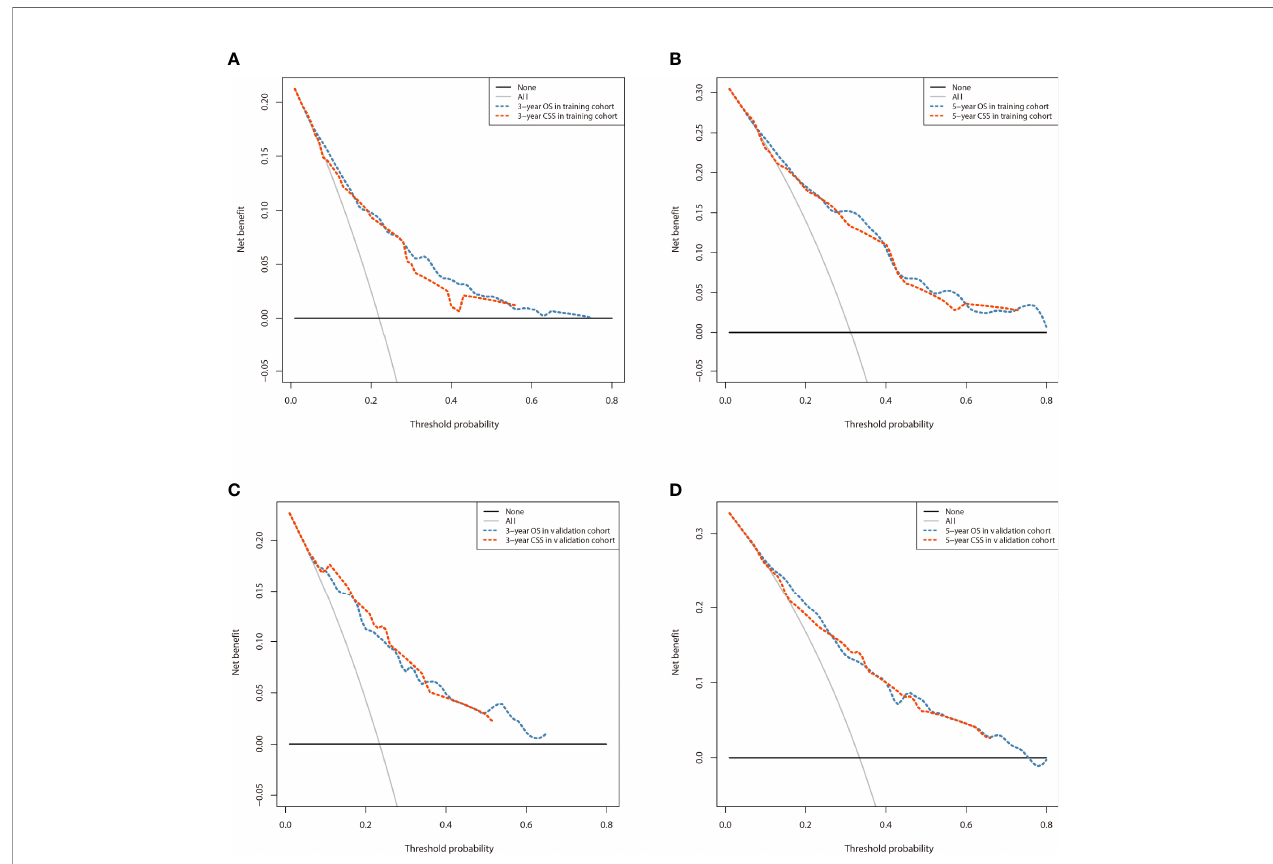
FIGURE 8 | Comparison of the DCA curves of the nomograms for 3- and 5-year OS and CSS prediction of the training cohort (A, B) and validation cohort (C, D)